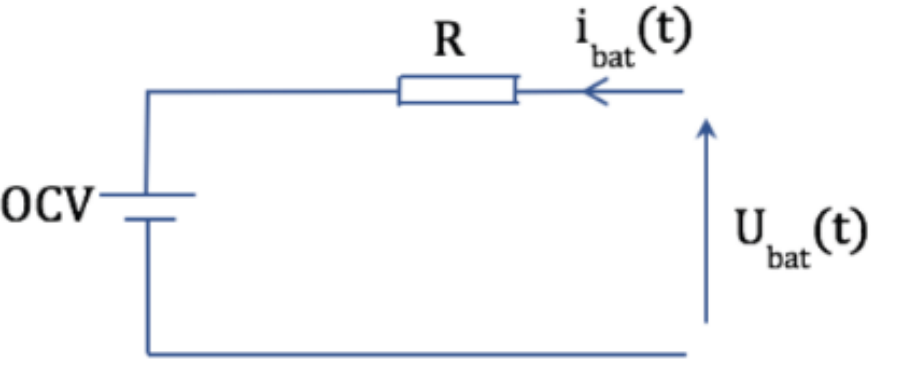
Figure 2. Battery electric model.